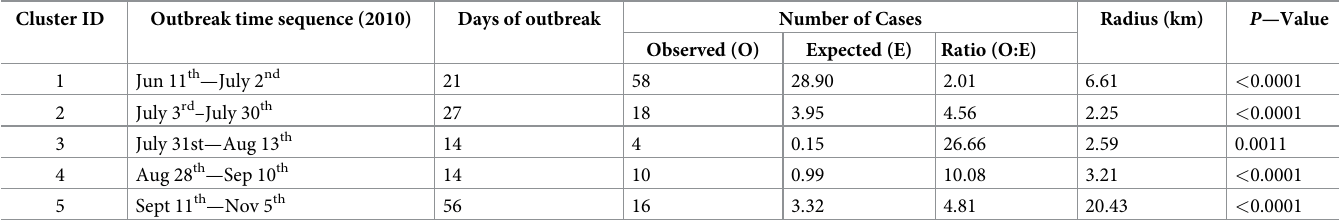
Table 3. Temporal characteristics of case clusters in Hippopotamus anthrax outbreaks of